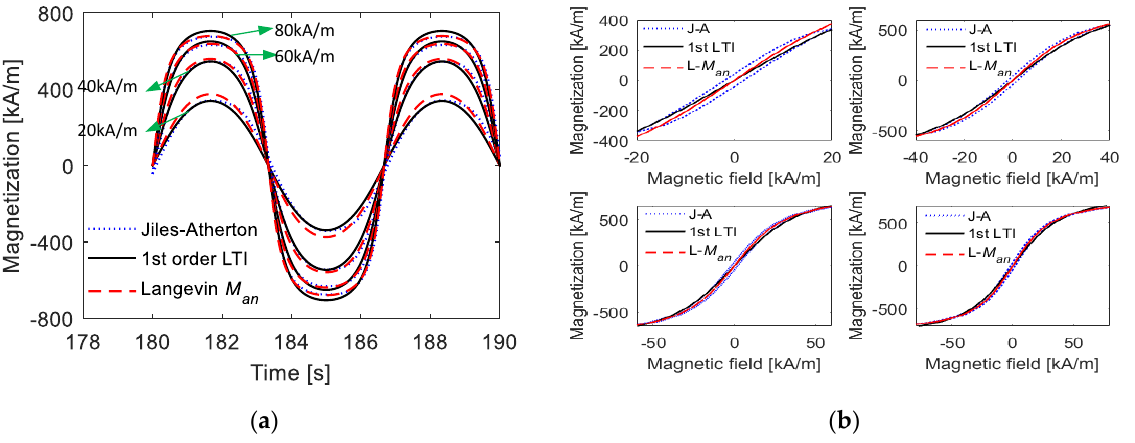
Figure 14. Comparisons of calculated magnetization curves from Jiles – Atherton model and the nonlinear simple model under fixed parameters ( k = 2 kA/m, a = 12 kA/m, c = 0.2, α = − 0.001 and M S = 80 kA/m) during various magnetic field intensities with high amplitudes: ( a ) time-domain curves; ( b ) M − H curves.